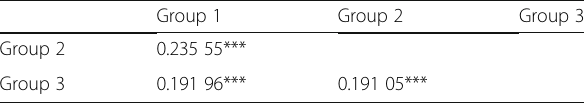
Table 4 Pairwise F ST estimates for the three groups corresponding to three major regions of cotton production as identified by